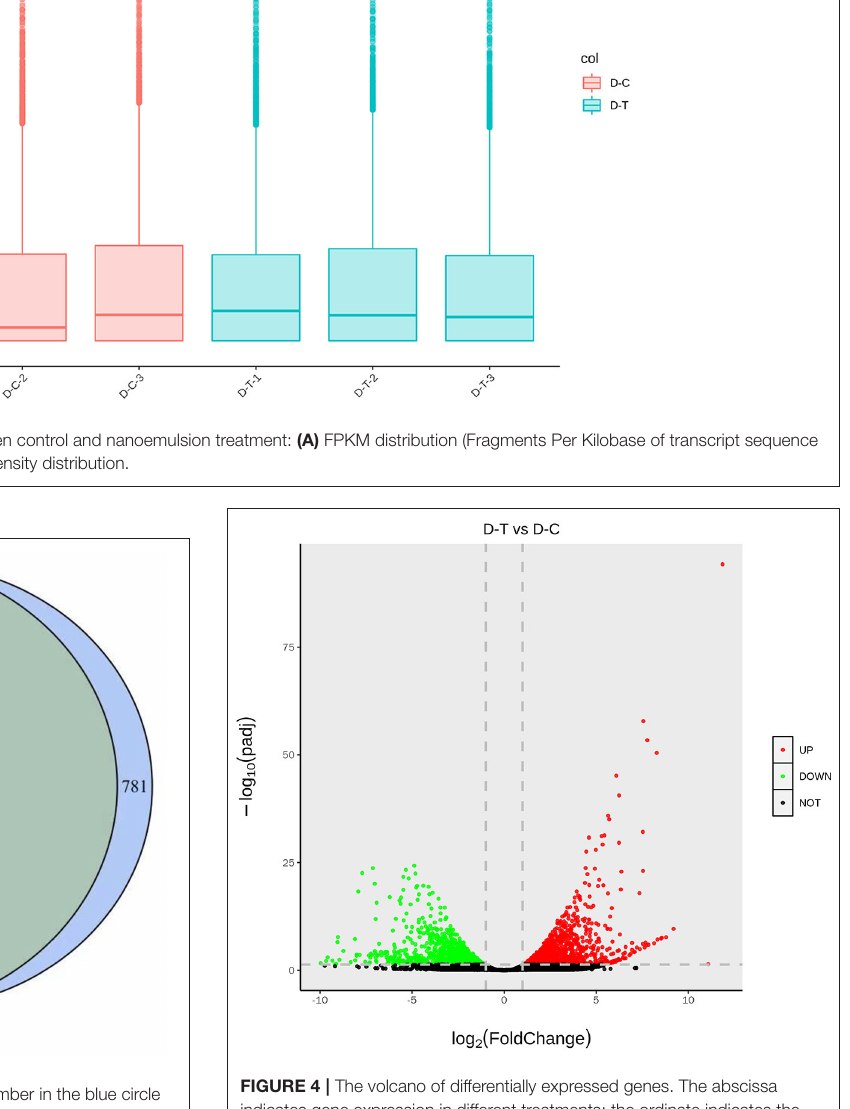
FIGURE 3 | Venn diagram of gene expression. The number in the blue circle and yellow circle indicates the total number of genes expressed in the control and nanoemulsion treatment samples, respectively, and the green part of circles indicates that the gene is co-expressed in both samples.